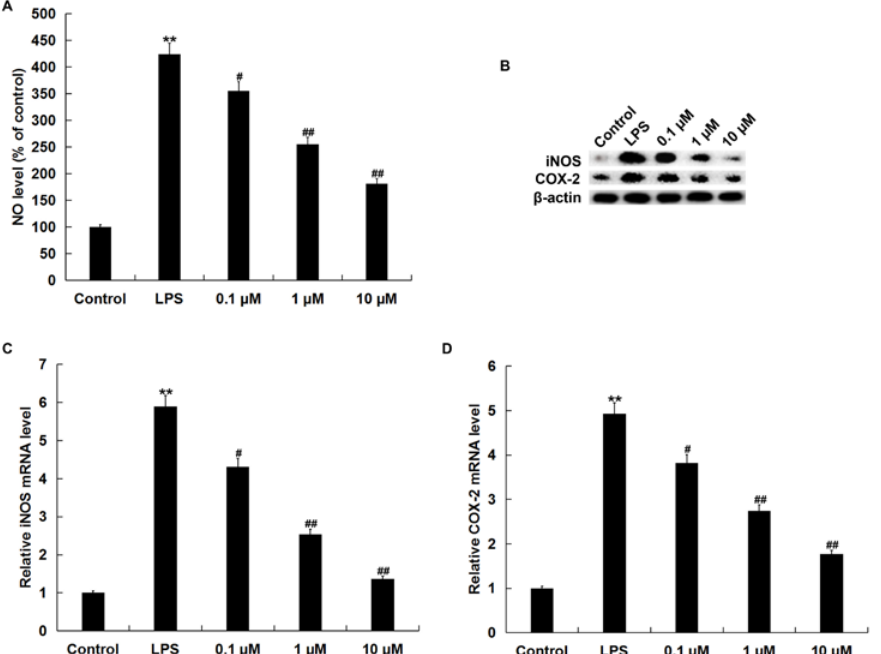
Figure 3: Effects of NGR1 on NO production, iNOS and COX2 expression in LPS-treated RAW264.7 cells. In addition to an untreated control sample, RAW264.7 cells were pretreated with various concentrations of NGR1 (0.1, 1 and 10 µ M) for 2 h and then treated with 1 µ g/ml LPS at 37˚C for 24 h. A: the secretion of NO was detected using the nitrate/nitrite assay kit; B: protein levels of iNOS and COX2 were measured by western blot assay; C and D: mRNA levels of iNOS and COX2 were measured by qRT-PCR. Data were expressed as the mean ± SD. **p<0.01 vs. control group; #, ## p<0.05, 0.01 vs. LPS treatment alone